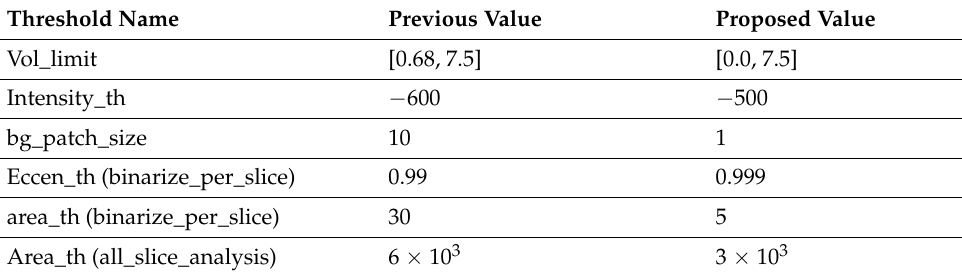
Table A2. Pre-processing threshold value